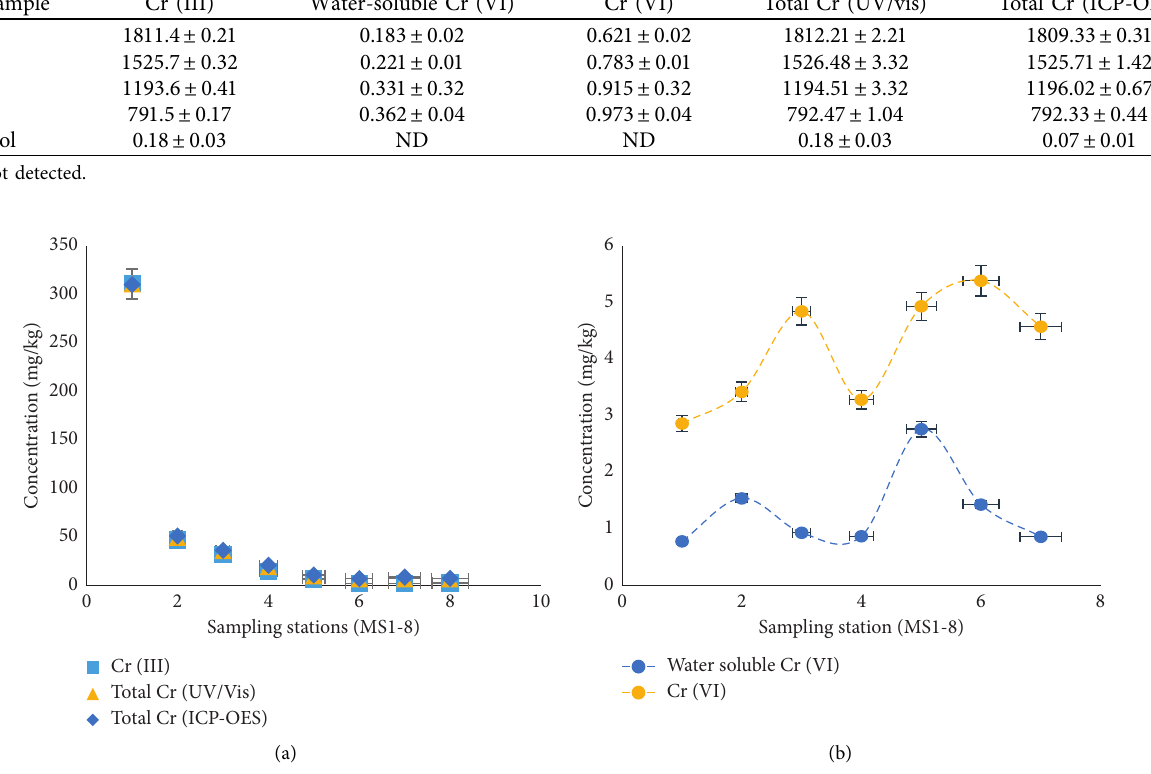
Figure 3: Concentration of chromium in the soil following the course of Modjo River (MS � Modjo soil samples) (mean ± SD mg kg − 1 , n �